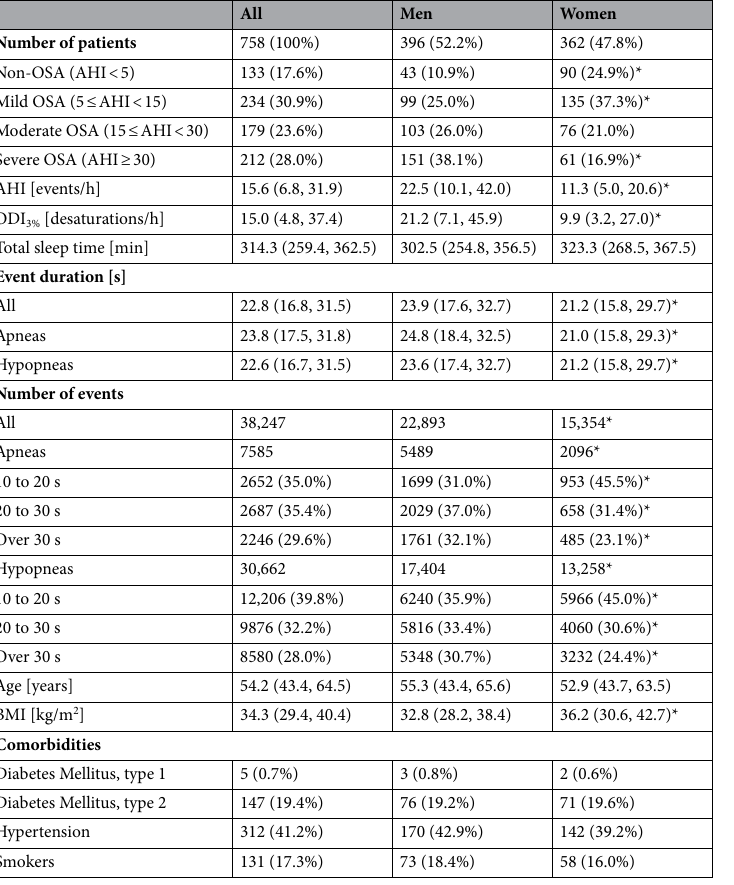
Table 1. Characteristics of the study population comprising suspected OSA patients. Values are presented as a median (interquartile range) for continuous variables and as a count (percentage) for discrete variables. Information about comorbidities was obtained from patient records. OSA obstructive sleep apnea, BMI body mass index, AHI apnea–hypopnea index, ODI 3% oxygen desaturation index based on AASM 2012 scoring criteria (desaturation ≥ 3%). *Statistically significant difference ( p < 0.001) between men and women. Mann– Whitney U test was used for continuous and χ 2 -test for discrete